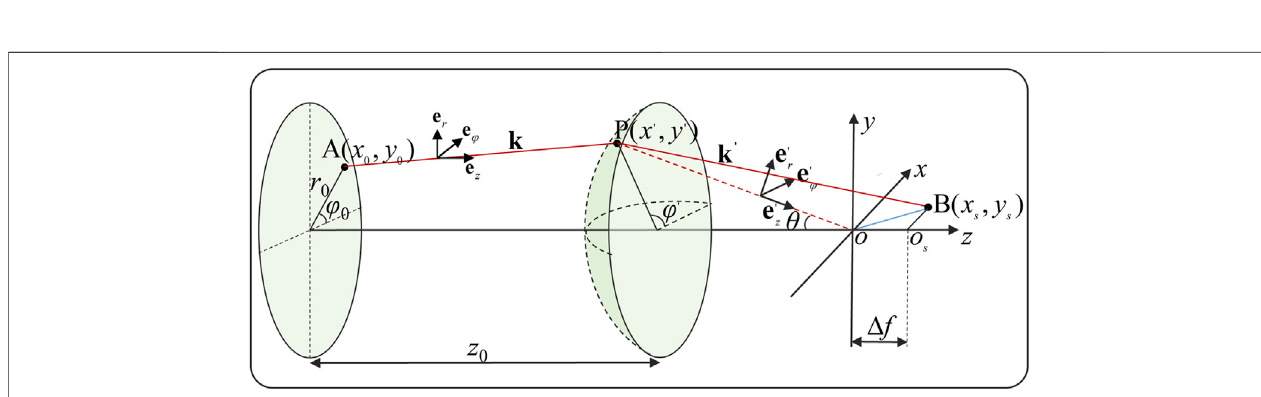
FIGURE5| Rotation angle predictedbytheoreticalderivations andthecorrespondingexperimental resultsforvortex beams withdifferenttopologicalcharges. (A) Rotation angle for vortex beams with different topological charges ( l equal to 0, 10, − 10, 20, and − 20) at the propagation distance. (B1 – B6) Corresponding measured intensity distributions and the rotation angles of (a1-a6) for truncated vortex beams. All images have the same dimension of 6.2 mm × 6.2 mm.